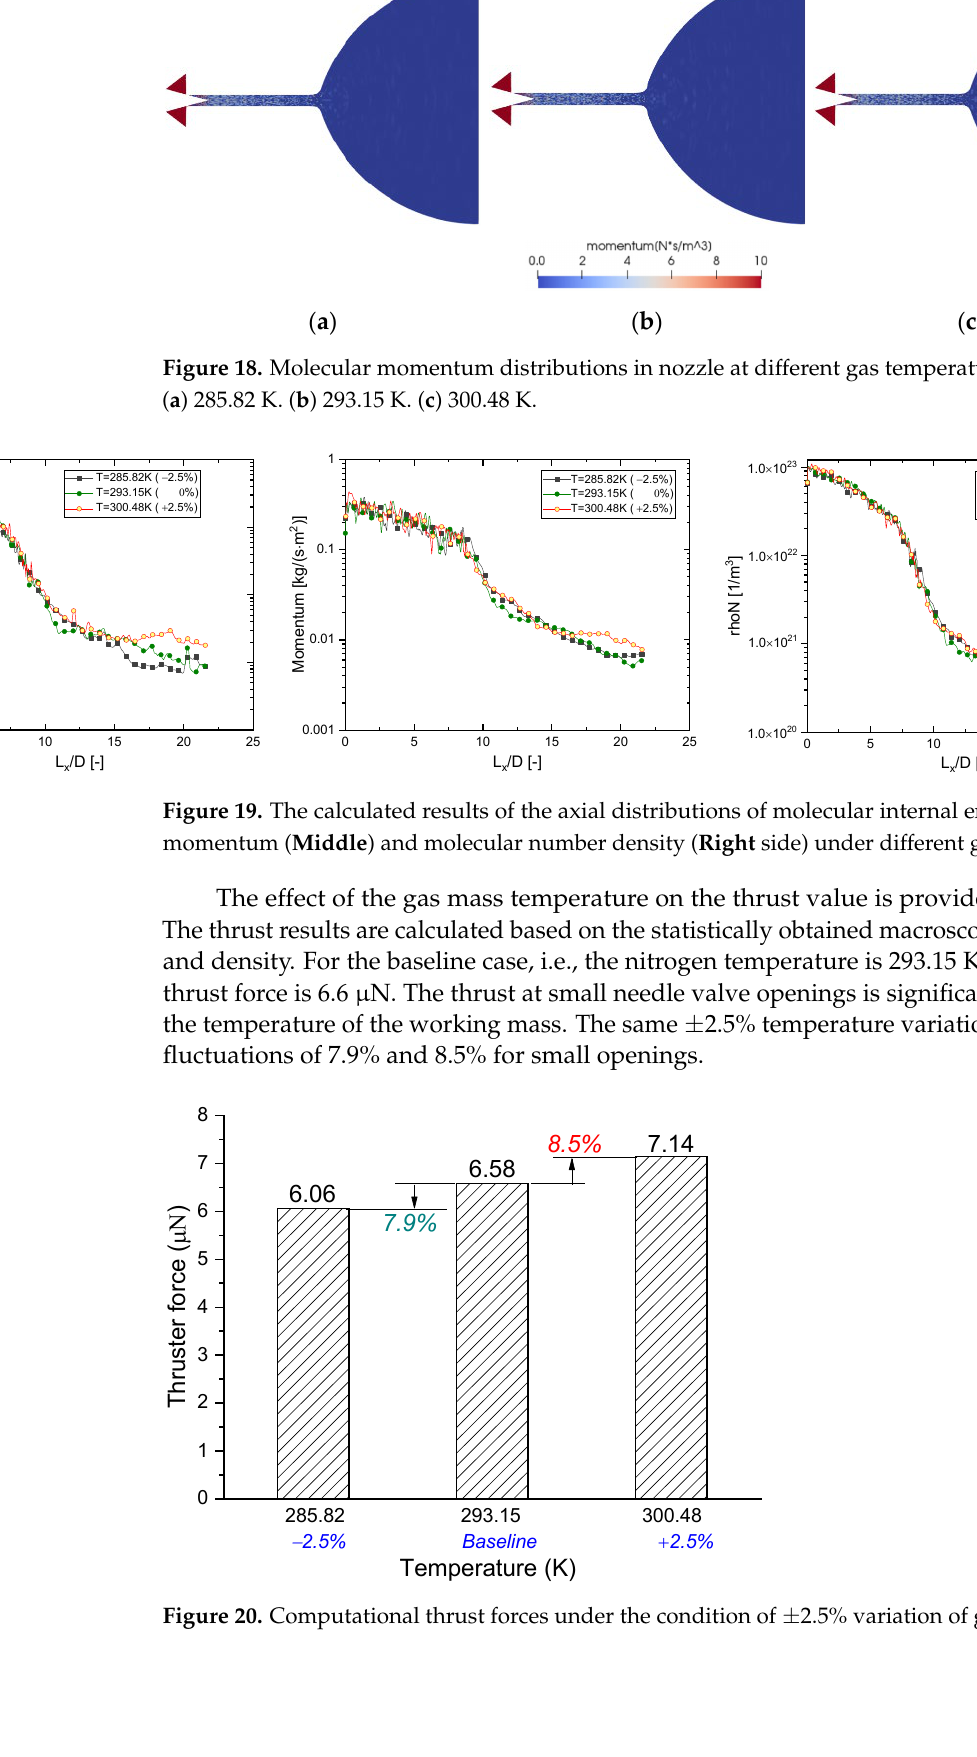
Figure 20. Computational thrust forces under the condition of ±2.5% variation of gas temperature.